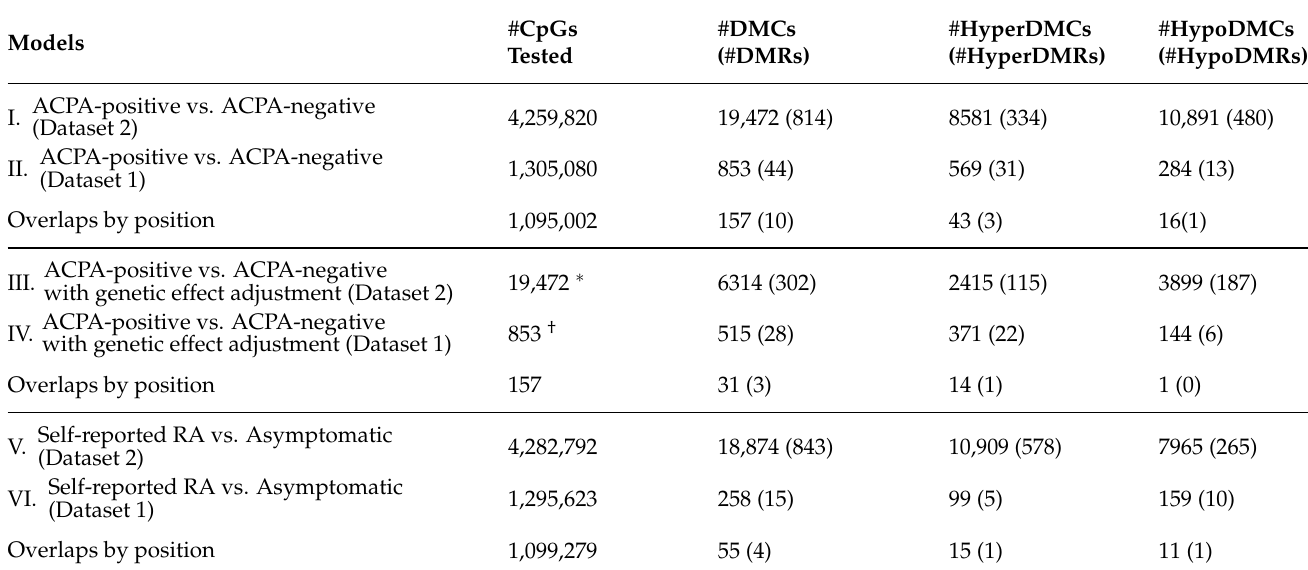
Table 3. Summary of different models fitted and corresponding identified DMCs/DMRs.